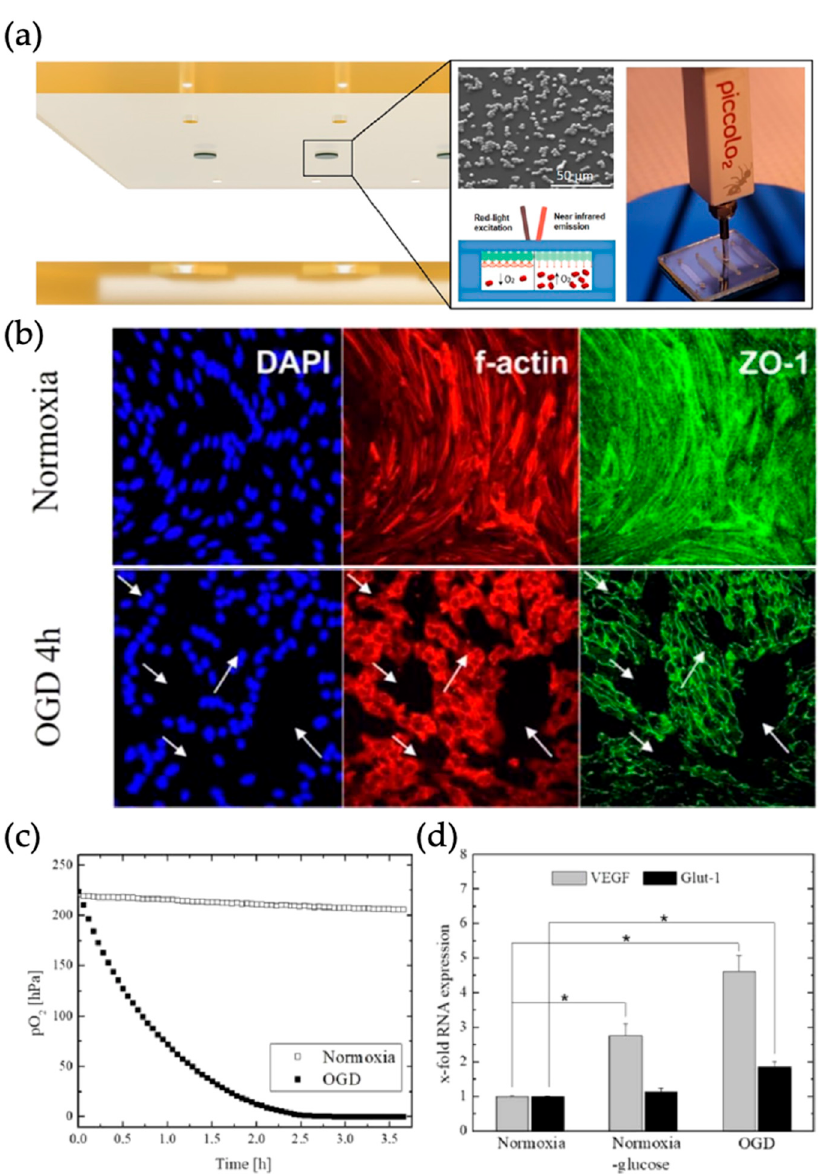
Figure 9. ( a ) Overview of microfluidic chip and oxygen sensing principle, particles have a size of 5 µm. ( b ) Morphology changes after 4-h period of normoxia conditions and under oxygen-glucose-deprivation (OGD). Arrows indicate ruptures in the cell barrier. ( c ) Oxygen measurement during normoxia conditions and under OGD. ( d ) Expression of VEGF and GLUT-1 in blood-brain-barrier model under normoxia (with and without glucose) and under OGD conditions. Reproduced with permission from [62] Copyright 2019 American Chemical